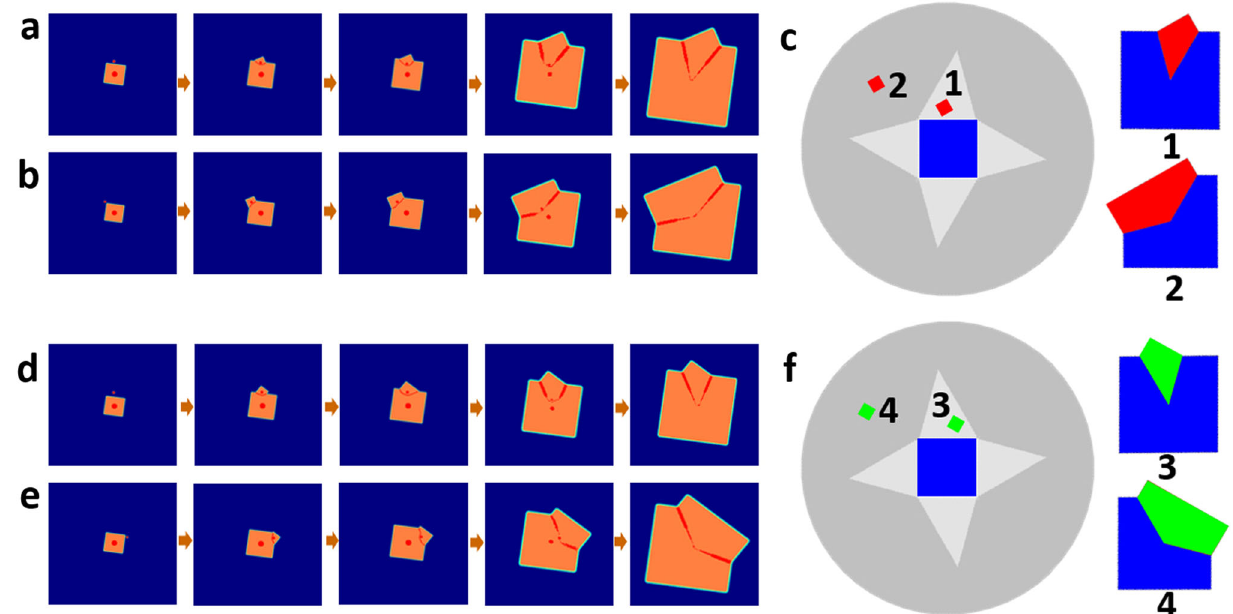
Fig. 7 Coalescence of two square 2D grains on a three- or six-fold symmetric substrate. a , b PFT simulations showing two coalescence processes of two square grains with an anti-clockwise misorientation angle of 30 o , respectively. The fi fth panels are zoomed out for a better view. c Topography diagram for the coalescence of two square 2D grains with an anti-clockwise misorientation angle of 30 o . In the left panel, the fi rst grain is represented by the blue square. The second grain (small red square) is nucleated in either light gray area 1 or dark gray area 1. Shape 1 or 2 in the right panel will be fi nally formed after coalescence between these two grains, with the second grain nucleated in area 1 or area 2, respectively. d , e PFT simulations showing two coalescence processes of two square grains with an anti-clockwise misorientation angle of 60 o , respectively. The fi fth panels are zoomed out for a better view. f Topography diagram for the coalescence of two square 2D grains with an anti-clockwise misorientation angle of 60 o